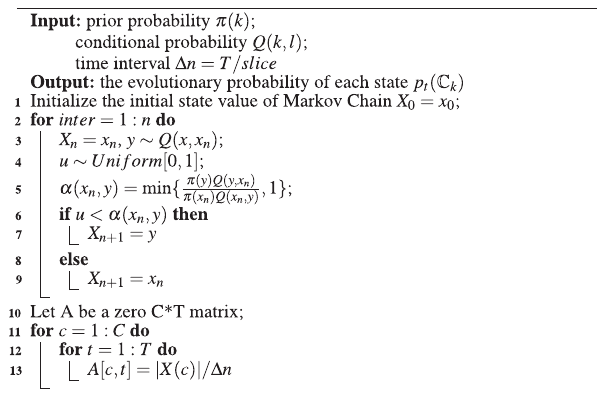
Algorithm 4. MCMC: Metropolis – Hastings algorithm